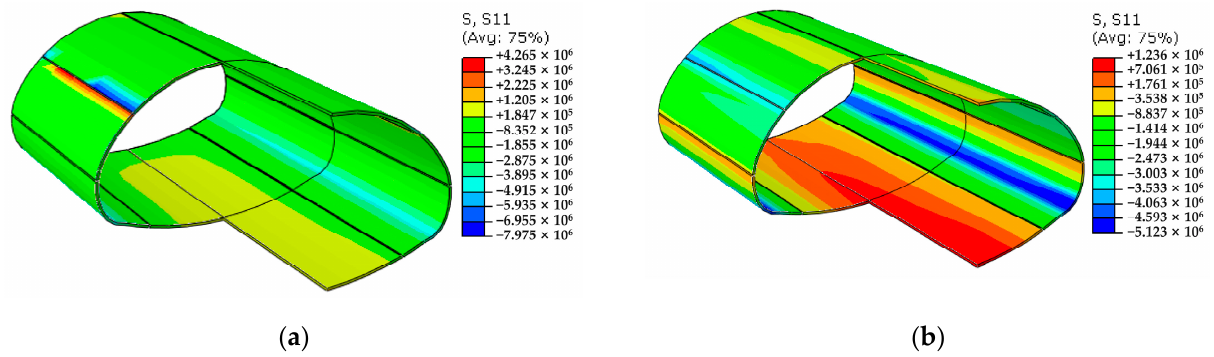
Figure 19. The horizontal stress of the temporary support in different conditions (unit: Pa): ( a ) Condition 1 and ( b ) Condition 2.